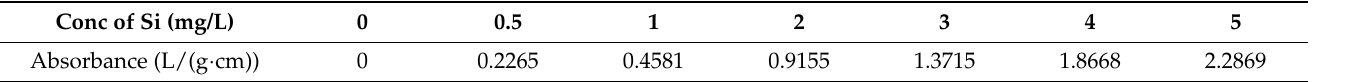
Table 3. The elemental Si standard curve values. Conc of Si (mg/L)